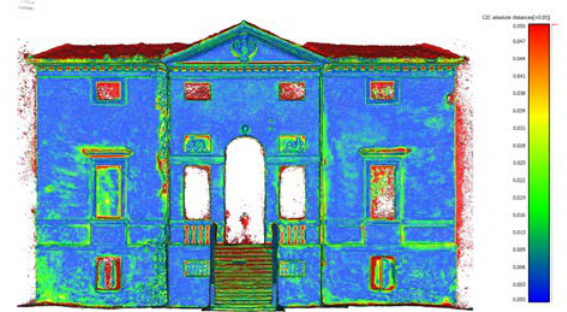
Figure 6. Comparison between point cloud from laser scanner and from photogrammetry. In red the area with an error- difference of 5 cm. In most cases, the areas in red are parts not surveyed by laser scanner because hidden from the sight due to scan position. They were surveyed, instead, by drone As a result, the use of ultra-light drones23 for this work made possible to get more details with the same accuracy of laser scanner ground scan as compared to the ground position. This approach has also the advantage of documenting even the hidden part of the architecture as moulding and roofs.